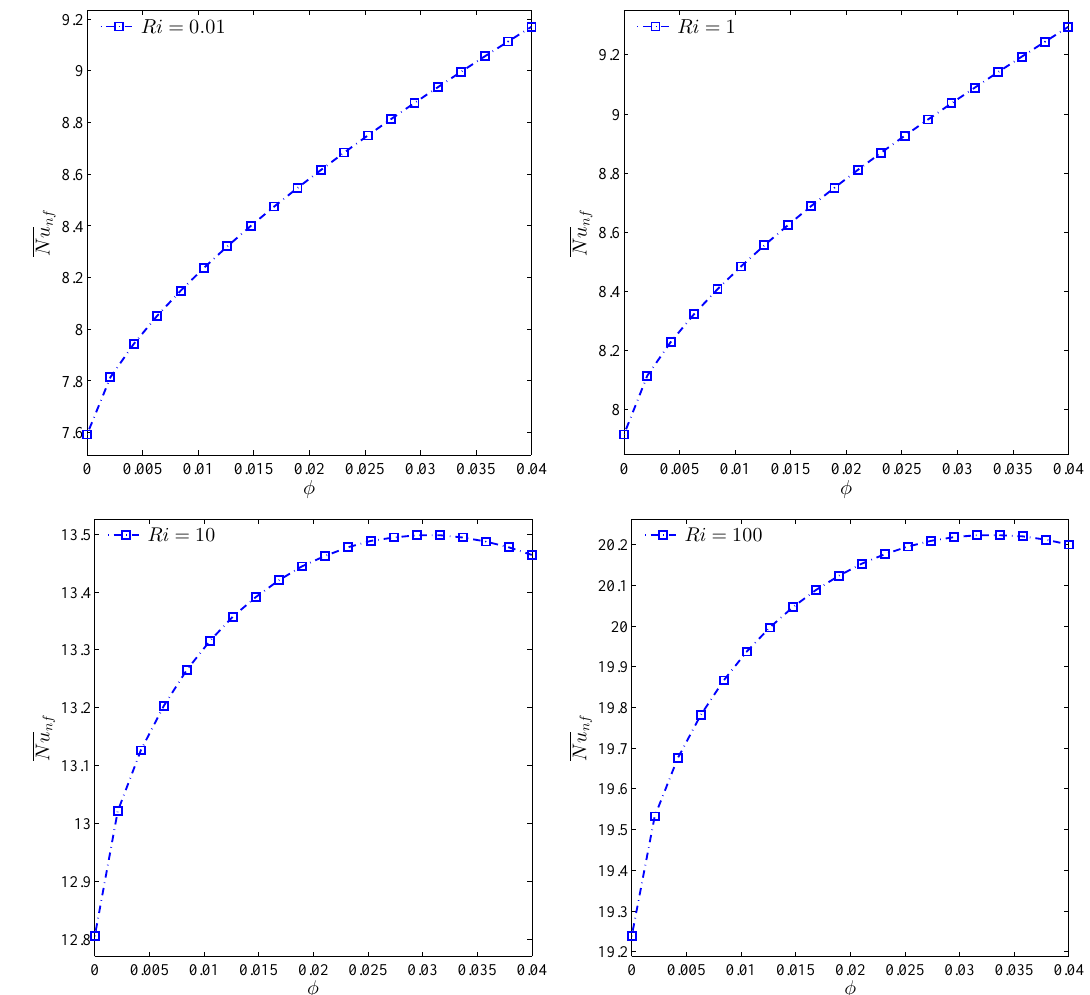
Figure 12. Plots of the average Nusselt number vs. φ for different Ri at Ha = 20 and D =